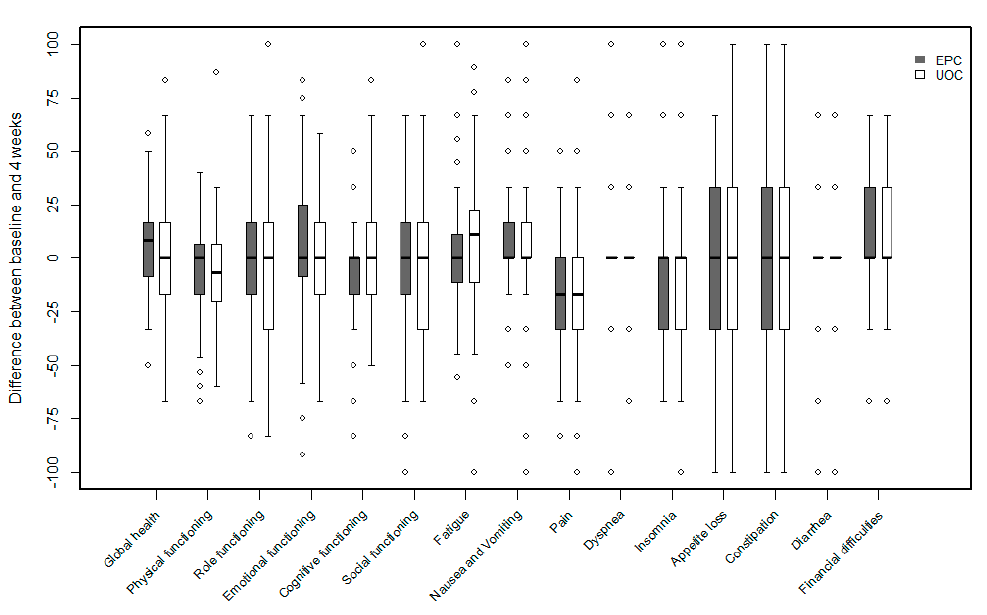
Figure 3. Box plot of differences of quality of life between baseline and 4 weeks.